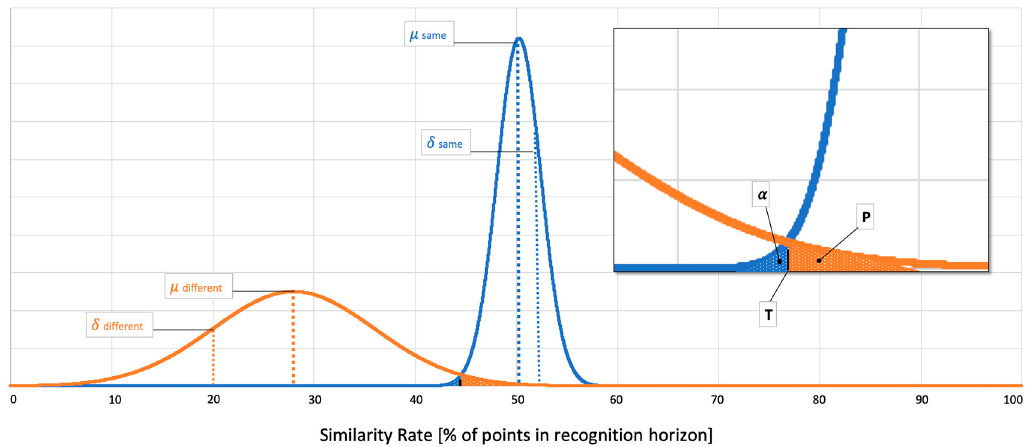
Figure 2. Example for two normally distributed probability curves (orange = between subject comparison; blue = within subject comparison; thin and thick dashed lines in orange and blue symbolize mean ( µ ) and standard deviation ( δ ); T is the border for rating di ff erent (left of T) and same (right of T); α -area = probability of not identifying a subject; P-area = probability of a false positive identification)